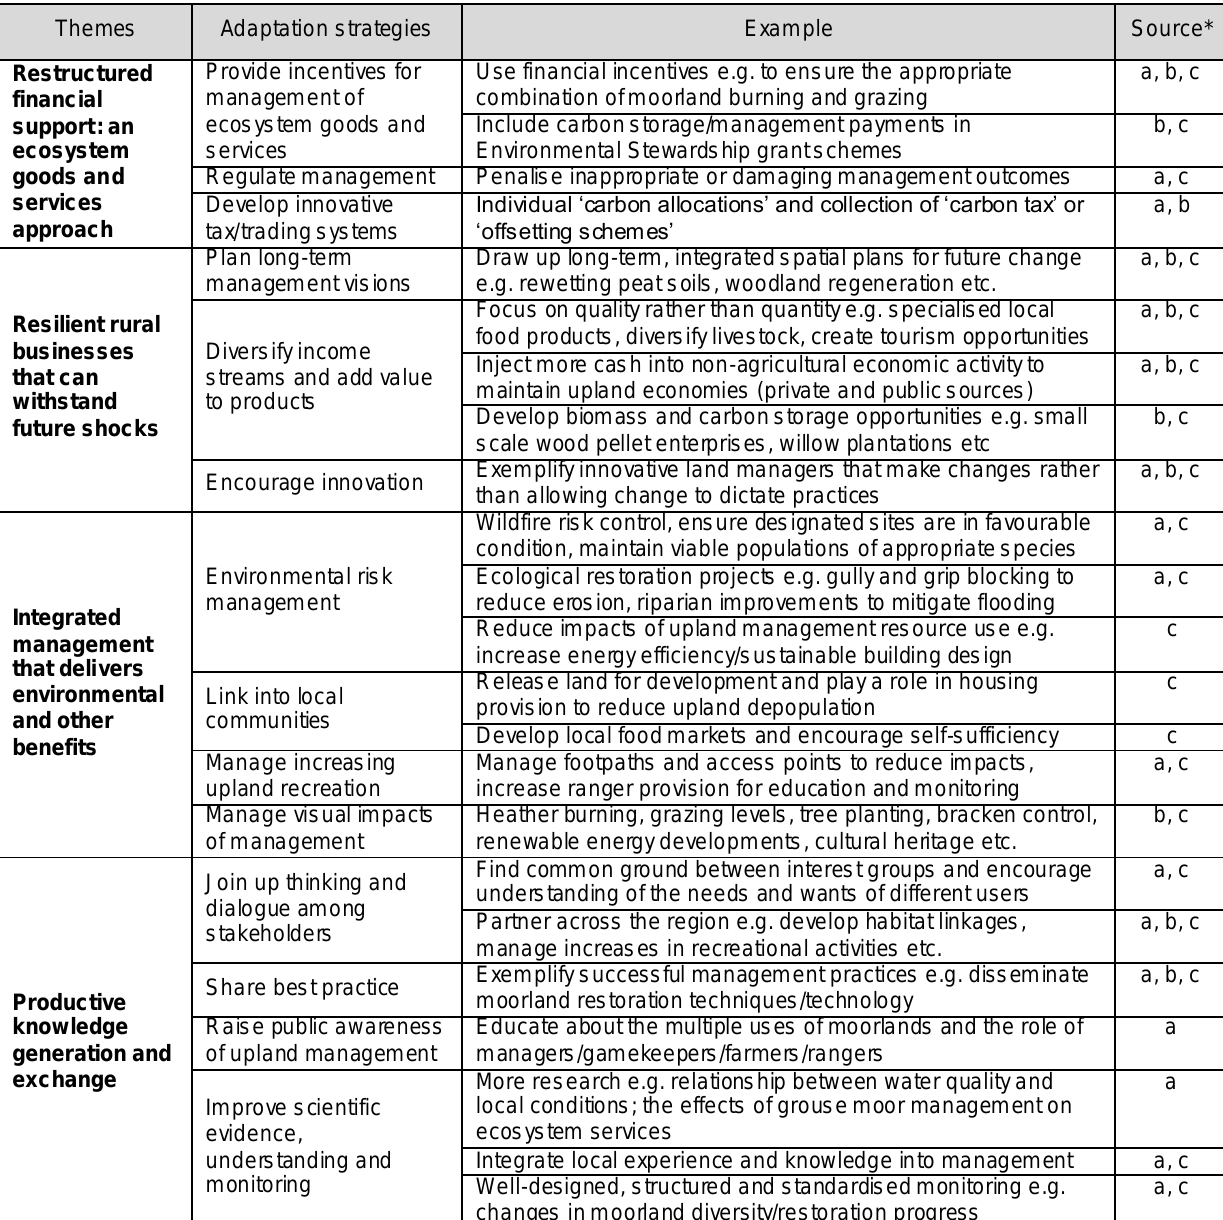
Table 1: Opportunities to reduce trade-offs and enhance complementarities between different forms of land use and management in UK uplands (results compiled from the Sustainable Uplands Project site visits and expert workshop and the Sustainable Estates project (Glass et al., 2011) (from Reed et al. . ,